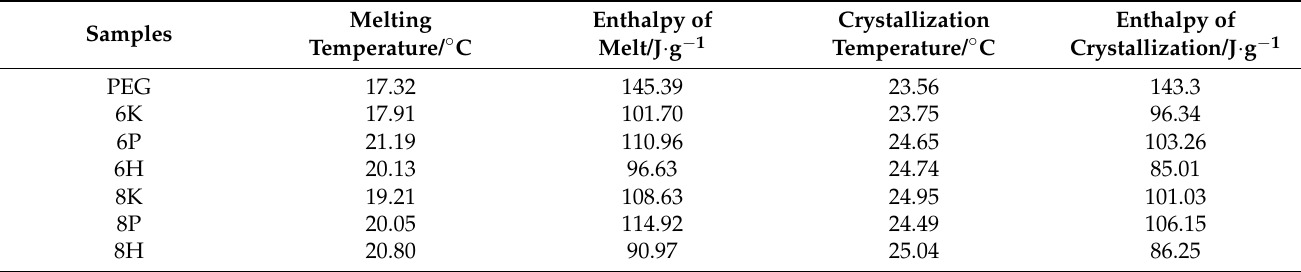
Figure 6. ( a ) Infrared thermal imaging of 8CPP and PEG; DSC of the composite material and PEG under activation at ( b ) 600 ◦ C and ( c ) 800 ◦ C. Table 1. Phase transition temperature and phase change enthalpy of PEG and porous carbon mate- rials.